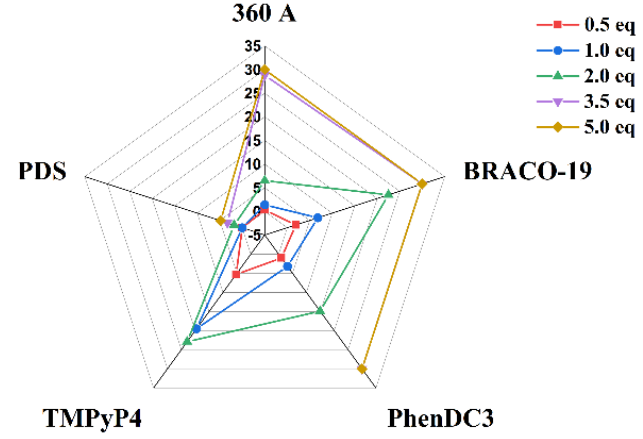
Figure 5. T m radar plot of AT11-L2 in the presence of different molar equivalents of tested ligands obtained by CD-melting experiments .